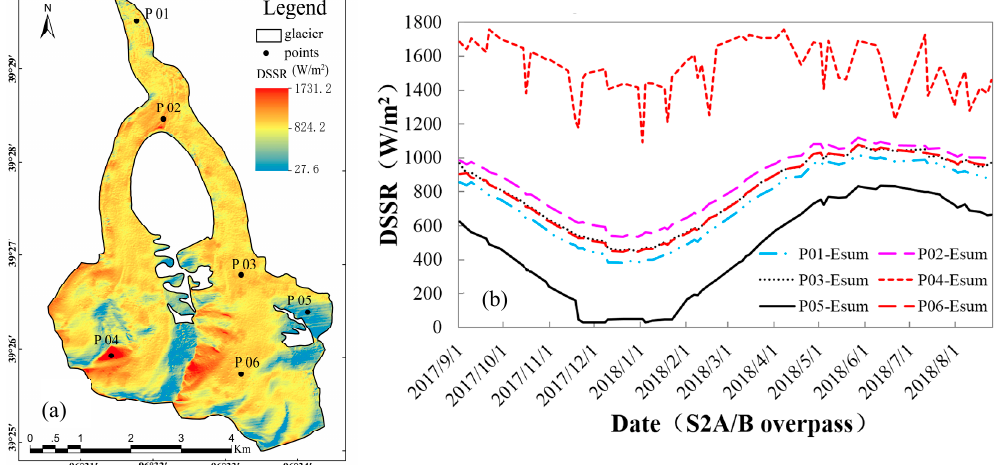
Figure 7. Spatiotemporal variation in the DSSR over a mass-balance year at the S2A/B overpass time on 1 September 2017: ( a ) locations of the six points on the DSSR map and ( b ) spatiotemporal variation curves of the solar irradiance.